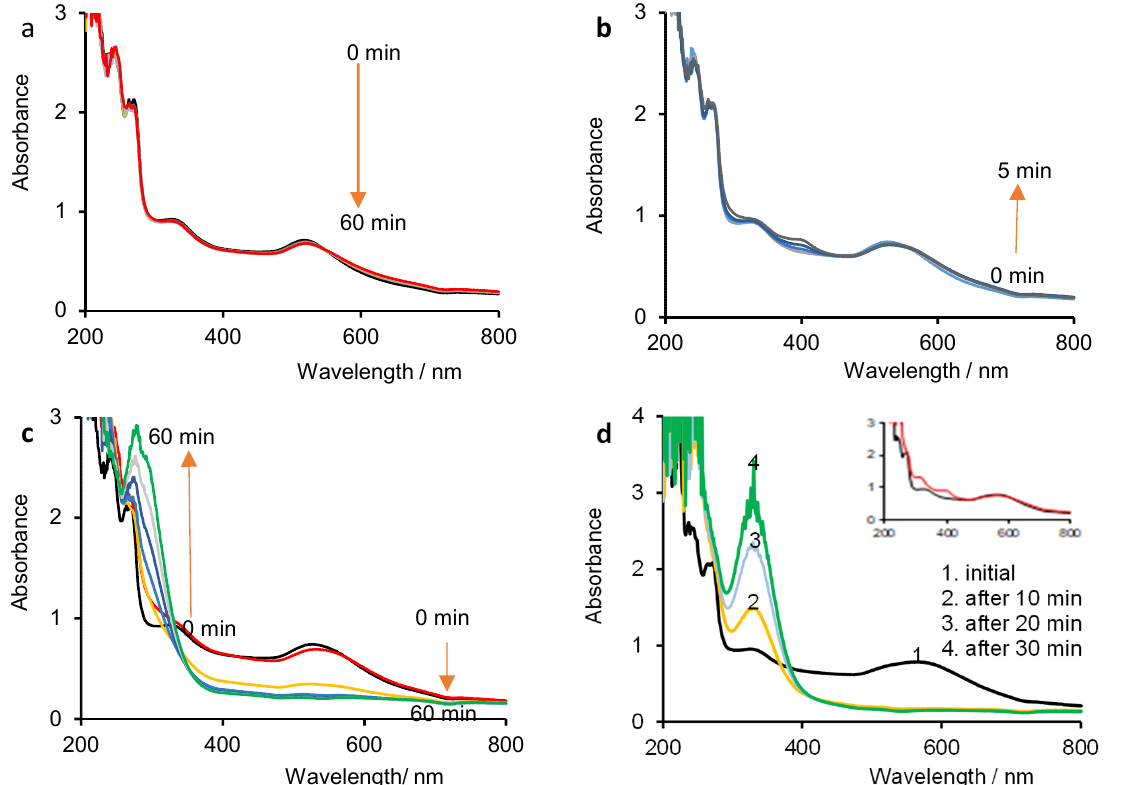
Figure 8. UV-Vis spectra recorded before and during constant current density electrolysis: ( a )—in 0.1 mol L − 1 NaF solution containing 6.65 × 10 − 5 mol·L − 1 VK and 75 mg·L − 1 AuNPs (NaF–VK–AuNPs); ( b )—in 0.1 mol L − 1 NaCl solution containing 6.65 × 10 − 5 mol·L − 1 VK and 75 mg·L − 1 AuNPs (NaCl– VK–AuNPs), every minute—from initial time to five minutes; ( c )—in 0.1 mol L − 1 NaCl solution containing 6.65 × 10 − 5 mol·L − 1 VK and 75 mg·L − 1 AuNPs (NaCl–VK–AuNPs), every 10 min—from